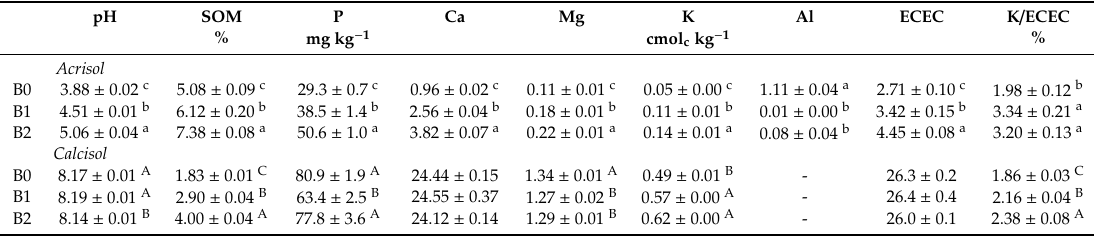
pH SOM Table 2. The soil properties at the end of the leaching experiment. Mean ± standard error (n = 4). pH